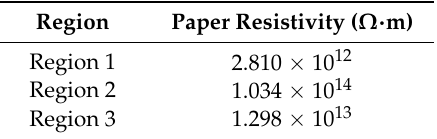
Figure 13. Iterative results of paper resistivity values for each region. Table 4. Final results of paper resistivity iterative